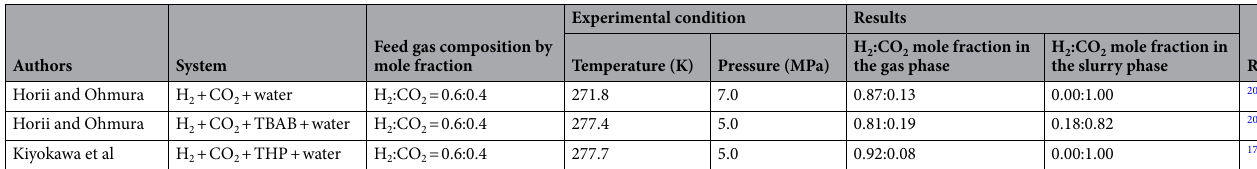
Table 1. Summary of experimental results of continuous CO 2 -separation